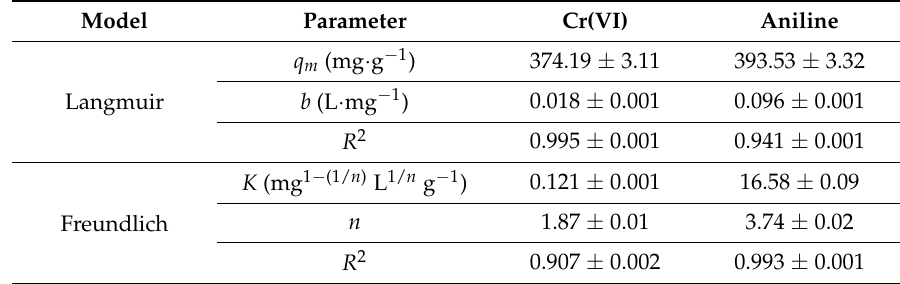
Table 3. Adsorption isotherm models using MFH at T = 298K.